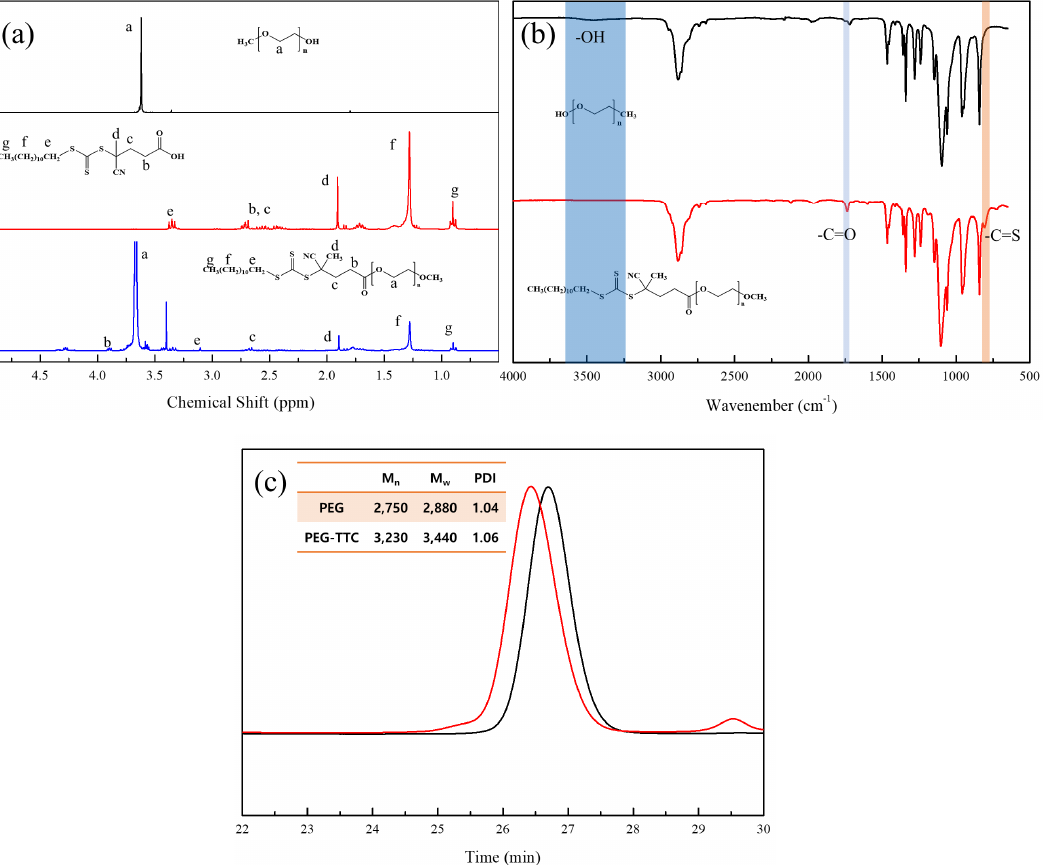
Figure 3. Macro RAFT agent (PEG-TTC) of ( a ) 1 H NMR spectra, ( b ) FTIR spectra, ( c ) GPC measurements.